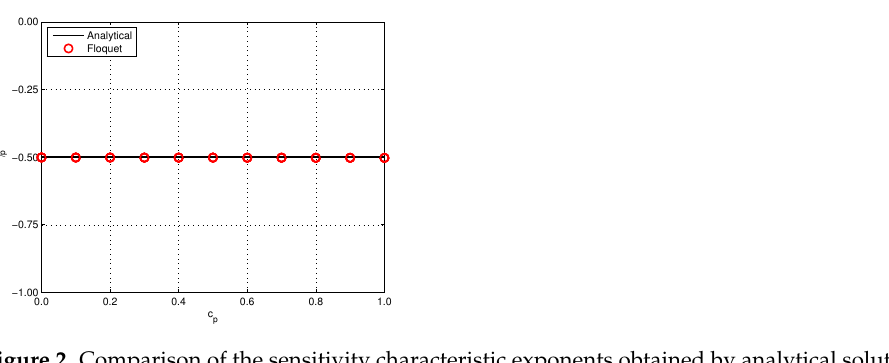
Figure 2. Comparison of the sensitivity characteristic exponents obtained by analytical solution and numerical method